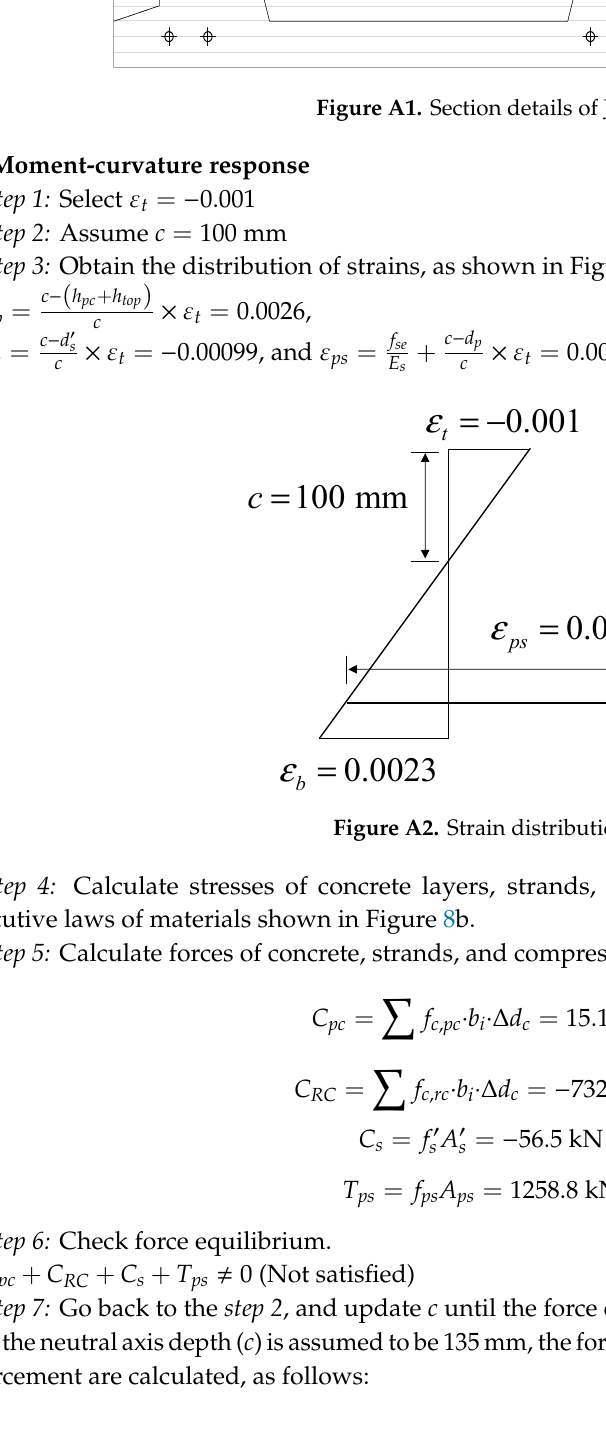
Figure A1. Section details of JAS.